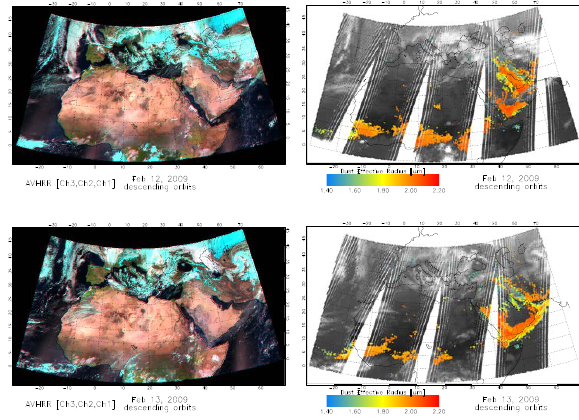
Fig. 4. IASI morning orbit observations of Dust AOD 0.5µm (colours) and IIS temperature (greyscale) for 11–14 February 2009 (top left to bottom right).